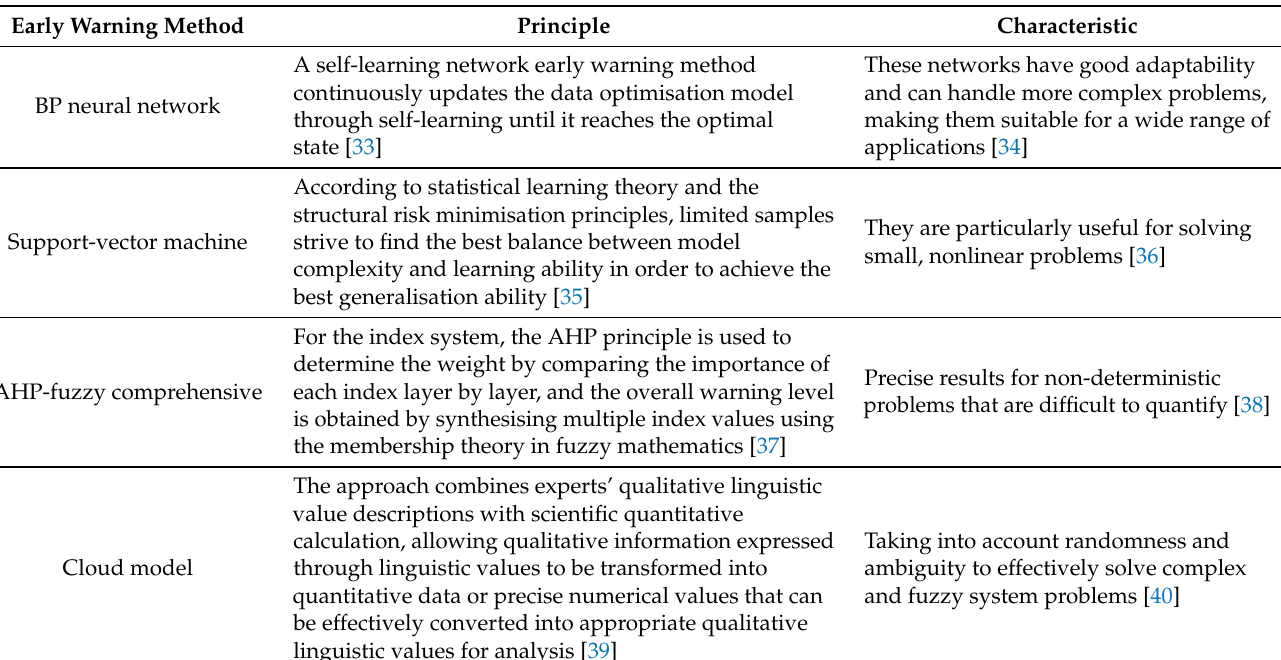
Table 8. Principles and characteristics of multi-index comprehensive early warning